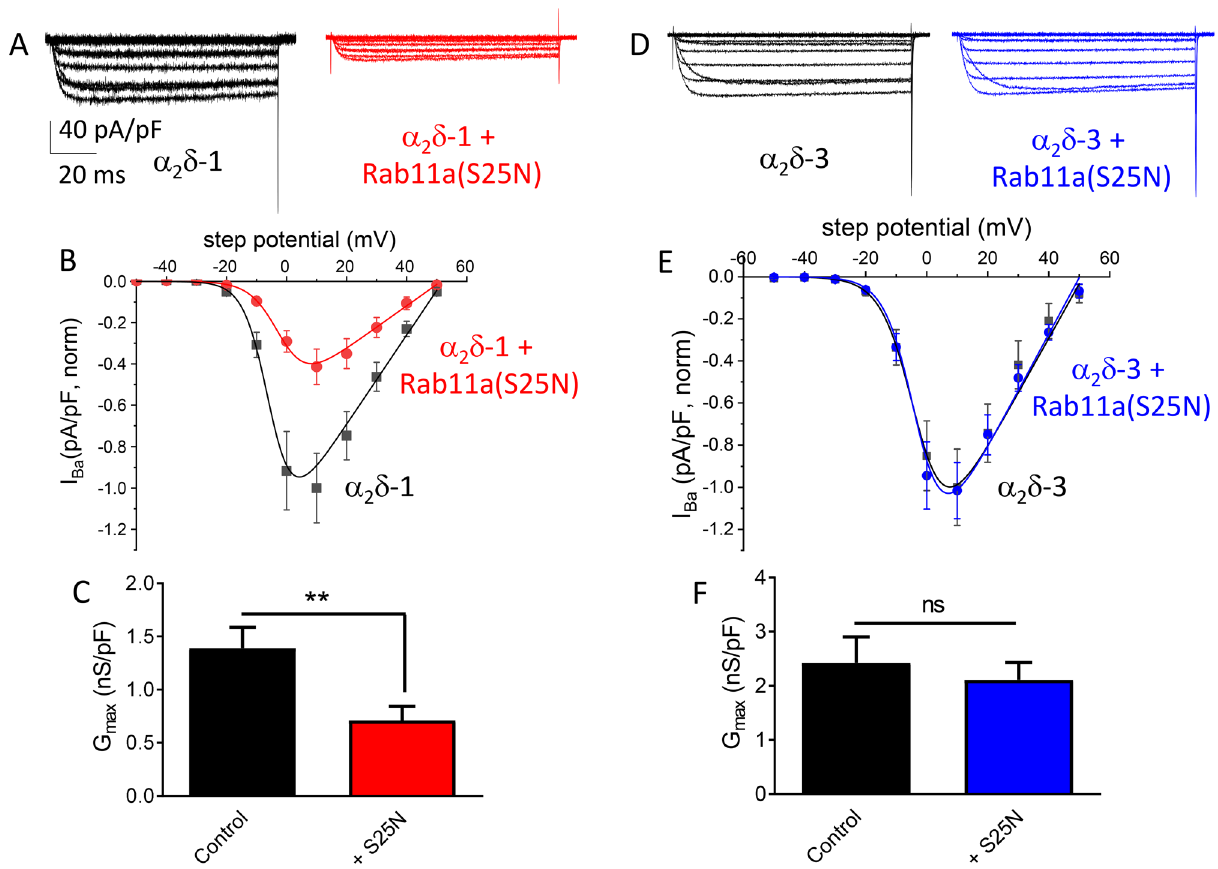
Figure 4. Rab11a(S25N) reduces whole-cell Ca V 2.2 currents when expressed with α 2 δ-1, but not α 2 δ-3. ( A ) Example whole-cell current traces for Ca V 2.2 expressed in tsA-201 cells with: β1b/α 2 δ-1 (black) and β1b/ α 2 δ-1 + Rab11a(S25N) (red). Scale bars (40 pA/pF and 20 ms) refer to all traces. ( B ) Mean IV plots for Ca V 2.2 with: β1b/α 2 δ-1 (black squares, n = 15) and β1b/α 2 δ-1 + Rab11a(S25N) (red circles, n = 14), fitted by a modified Boltzmann function. The potentials for 50% activation were -4.23 ± 0.76 mV, and -1.39 ± 1.26 mV, respectively. ( C ) Mean G max values obtained by fitting each individual trace in (B) to a modified Boltzmann function Ca V 2.2/ β1b/α 2 δ-1 (black), Ca V 2.2/β1b/α 2 δ-1 + Rab11a(S25N) (red). Statistical significance determined by Student’s unpaired t-test; **, P = 0.0093. ( D ) Example whole-cell current traces for Ca V 2.2 with: β1b/α 2 δ-3 (black) and β1b/α 2 δ-3 + Rab11a(S25N) (blue). ( E ) Mean IV plots for Ca V 2.2 with: β1b/α 2 δ-3 (black squares, n = 15) and β1b/α 2 δ-3 + Rab11a(S25N) (blue circles, n = 14), fitted by a modified Boltzmann function. The potentials for 50% activation were -4.21 ± 1.59 mV and -3.93 ± 0.98 mV, respectively. ( F ) Mean G max values obtained by fitting each individual trace in ( E ) to a modified Boltzmann function Ca V 2.2/β1b/α 2 δ-3 (black), Ca V 2.2/β1b/ α 2 δ-3 + Rab11a(S25N) (blue). Data are plotted as mean ± SEM. Statistical significance determined by Student’s unpaired t-test; ns, P =